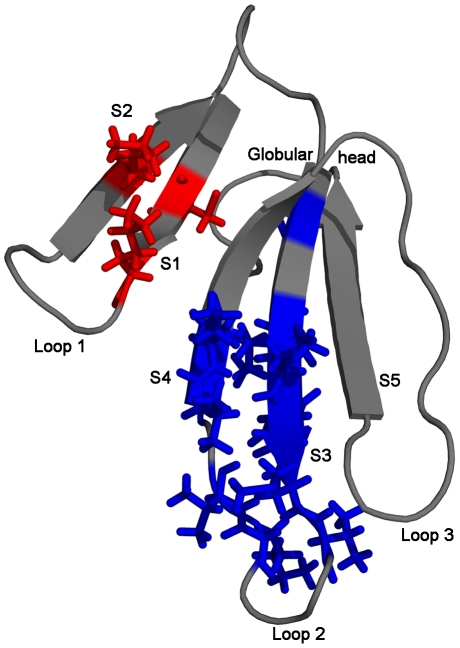
Possible existence of cryptic intermediates of CTX III.The five β-strands (S1–S5), three loops and a globular head in the structure of CTX III (2CRT) are shown by ribbon diagram. The blue and red sticks represent residues in the cryptic intermediates I & II, respectively, as predicted by OneG program.